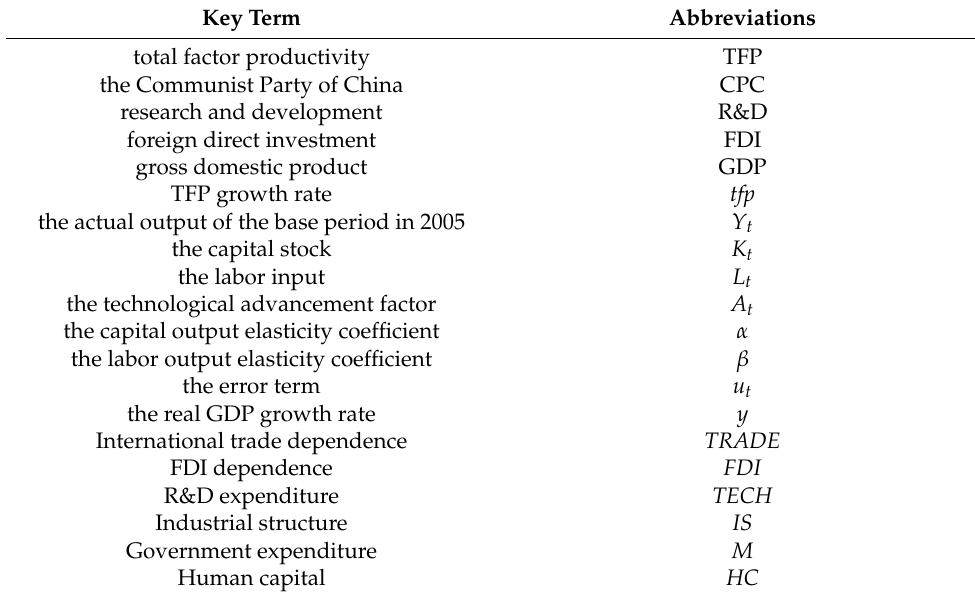
Table A1. The abbreviations of key